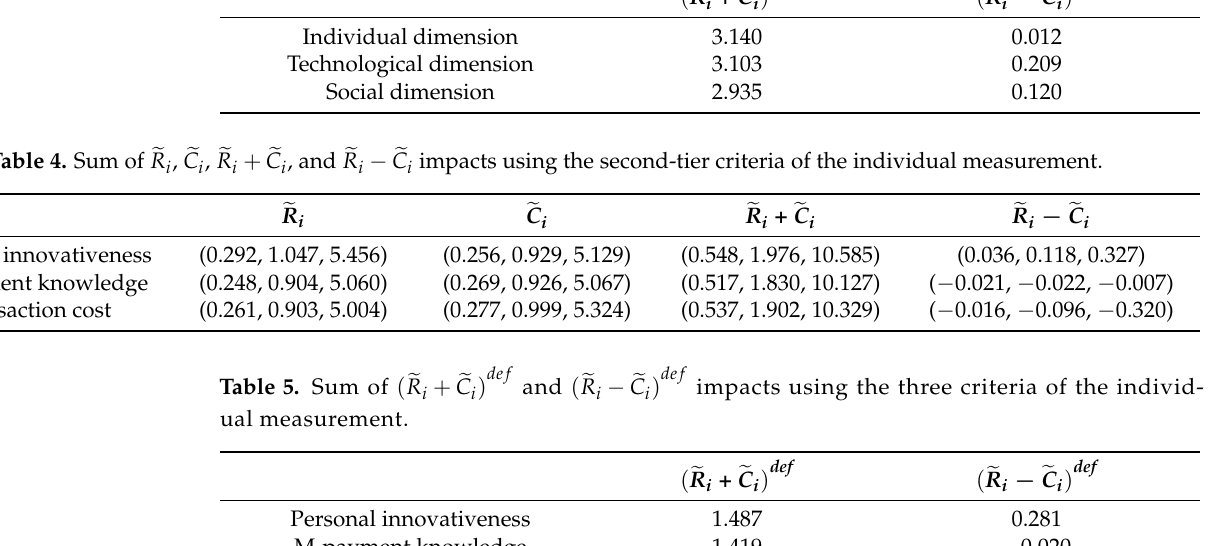
Table 3. Sum of ( (cid:101) R i + (cid:101) C i )